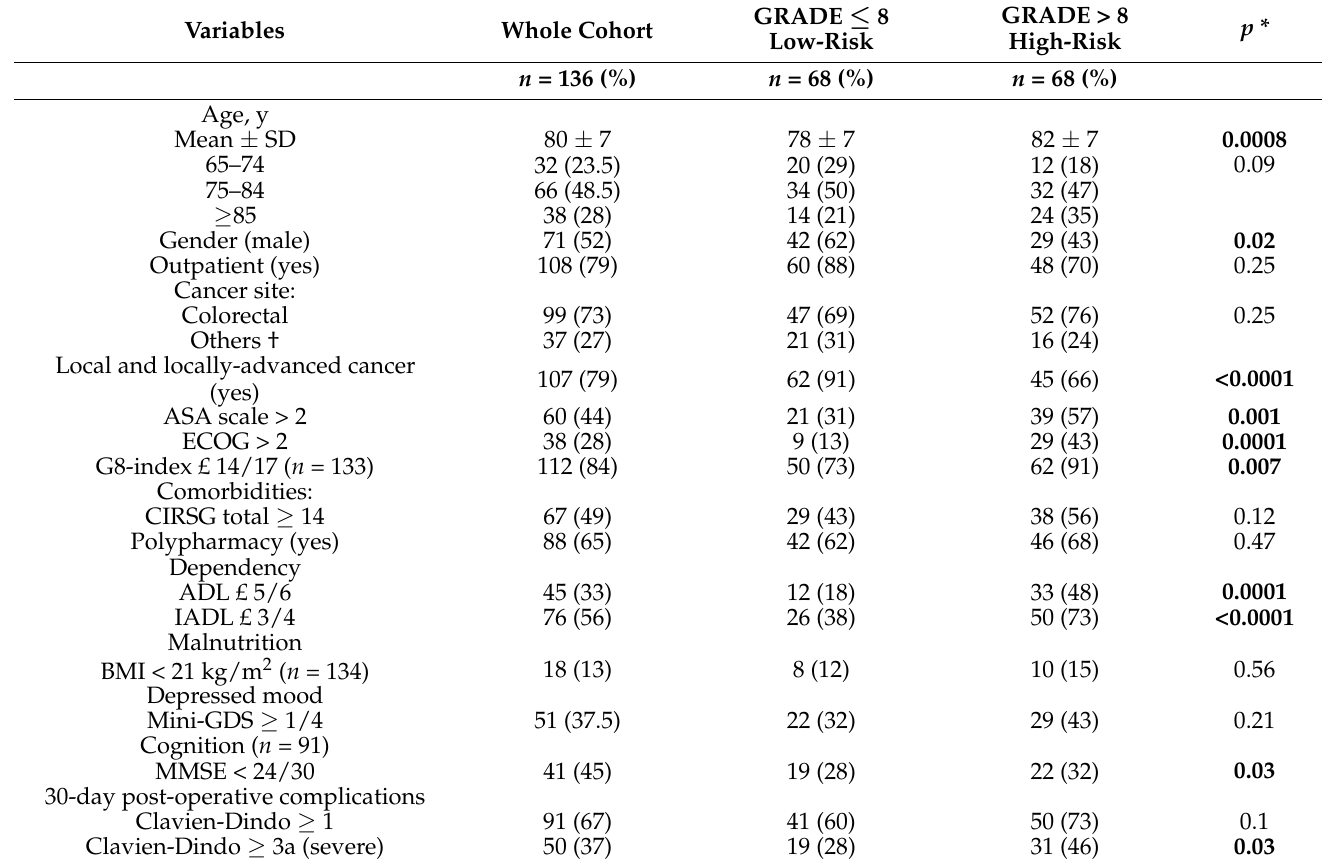
Table 1. Baseline characteristics and comparison of 136 older patients with major cancer surgery according to the GRADE